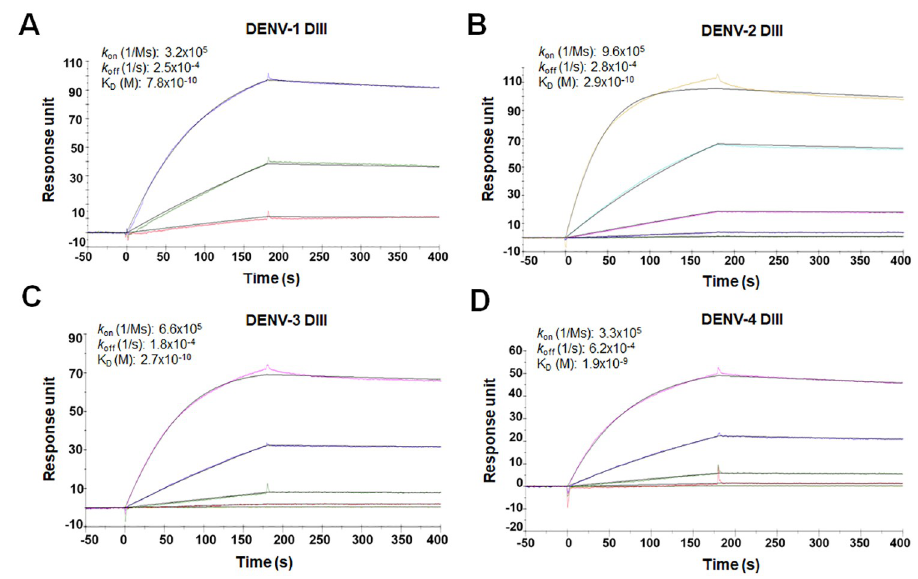
Fig 2. Binding of m366.6 to DENV DIIIs from the four serotypes measured by Biacore. The m366.6 was immobilized onto a CM5 chip, and the analytes consisted of serial dilution of DIII from DENV-1 (A), DENV-2 (B), DENV-3 (C), or DENV-4 (D). Binding kinetics was fitted using a 1:1 Langumir binding model by BIAevaluation 3.2